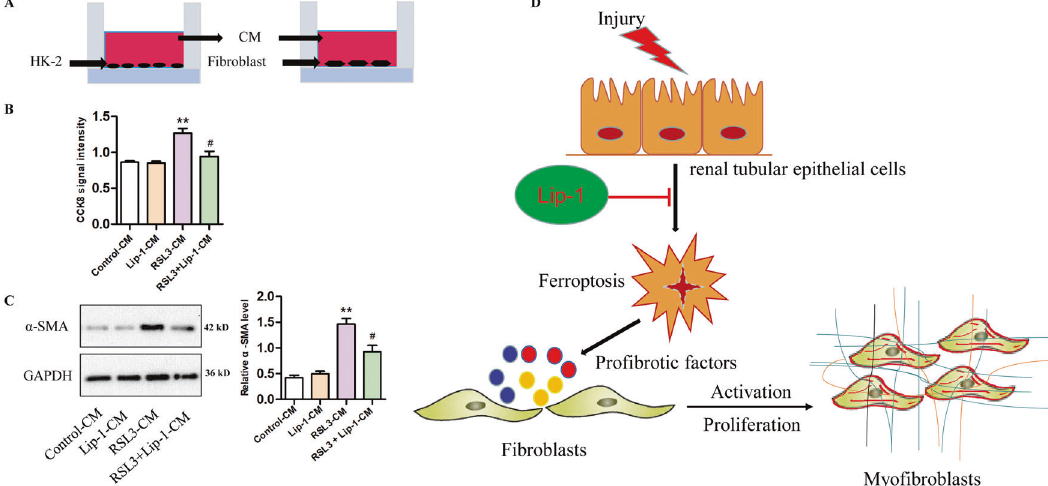
Fig. 7 Effects of HK2 cells conditioned medium on fi broblast activation and proliferation. A Experimental design. B Viability of fi broblast, evaluated by the CCK-8 assay ( n = 3, ** P < 0.01 vs control-CM group; # P < 0.05 vs RSL3-CM group). C Protein expression of α -SMA in fi broblast, determined by western blotting ( n = 3, ** P < 0.01 vs control-CM group; # P < 0.05 vs RSL3-CM group). D Hypothetical model showing the role of renal tubular epithelial cells ferroptosis in renal fi brosis and the effect of Liproxstatin-1. The data are presented as the mean ±